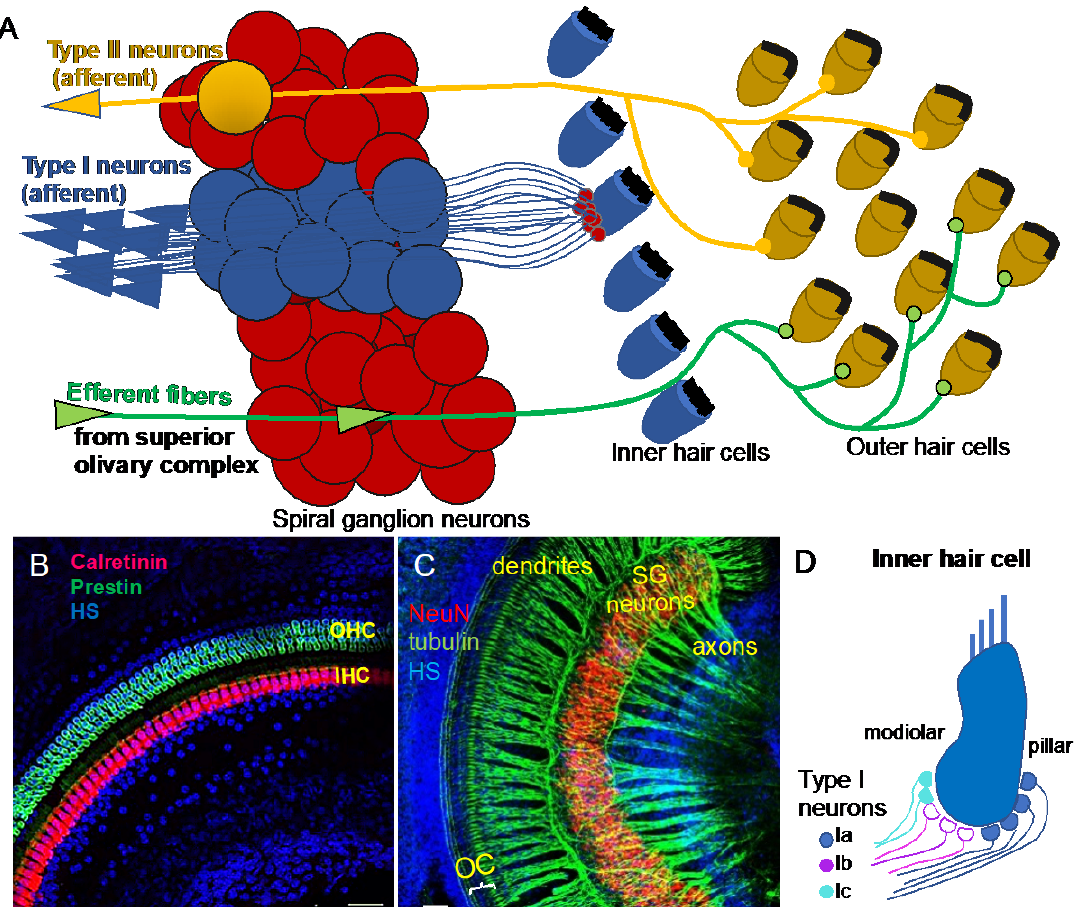
Figure 1. Auditory neurons form the spiral ganglion in the cochlea and connect hair cells in the organ of Corti to cochlear nuclei in the brain stem. ( A ) Diagram shows innervation of the organ of Corti. Type I neurons extend radial fibers toward the inner hair cells (5–30 type I neurons innervate one inner hair cell), and type II neurons provide diffuse innervations to the outer hair cells and supporting cells within the cochlea. Efferent axons from superior olivary complex innervate the outer hair cells. ( B ) Whole-mount immunolabeling of the mouse cochlea shows outer hair cells (OHC, labeled by anti-prestin) and inner hair cells (IHC, labeled by anti-calretinin) forming the organ of Corti (OC). ( C ) Whole-mount immunostaining of the spiral ganglion (SG) neurons (anti-NeuN, a neuronal soma marker) shows the dendrites extending in the periphery to the organ of Corti (OC) and the axons traveling to the central nervous system (anti-acetylated alpha-tubulin-labeled nerve fibers). Scale bars, 50 µ m. Confocal images ( B ) taken from [6] and ( C ) unpublished data. ( D ) Schematic drawing of synapses of molecular subtypes of type I neurons on the inner hair cell. Type I neurons are segregated into three distinct groups: types Ia (blue), Ib (magenta), and Ic (green-blue) of the spiral auditory neurons, which extend peripheral processes that are spatially segregated on the surface of the IHC. HS: Hoechst nuclear